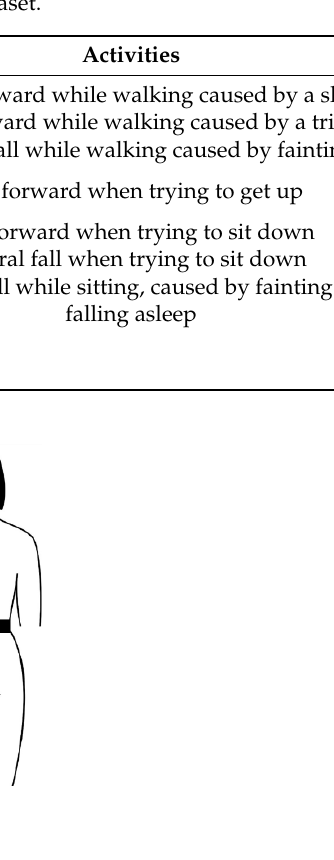
Table 1. Types of intentional falls contained in the SisFall dataset.